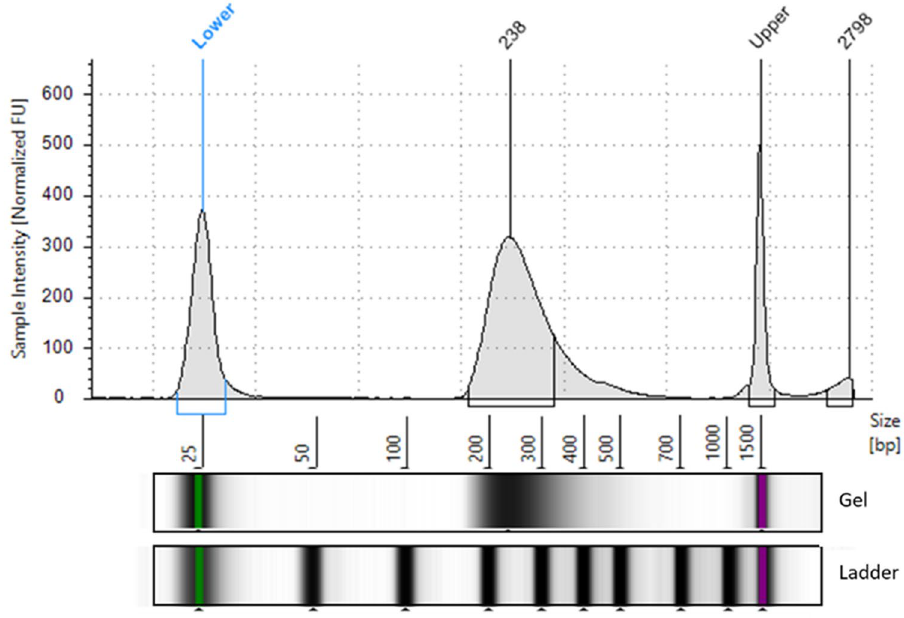
Figure 1. Distribution of fragment sizes in the enriched library used for WES.